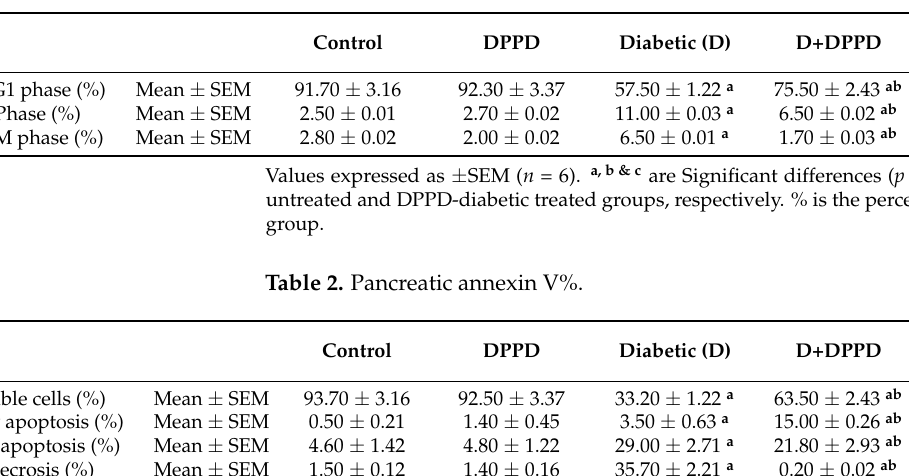
Table 1. Pancreatic cell cycle (G0/G1)%.